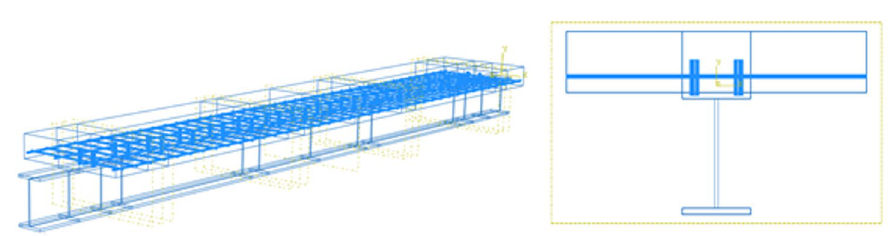
Figure 4. Slab embedded beam elements.